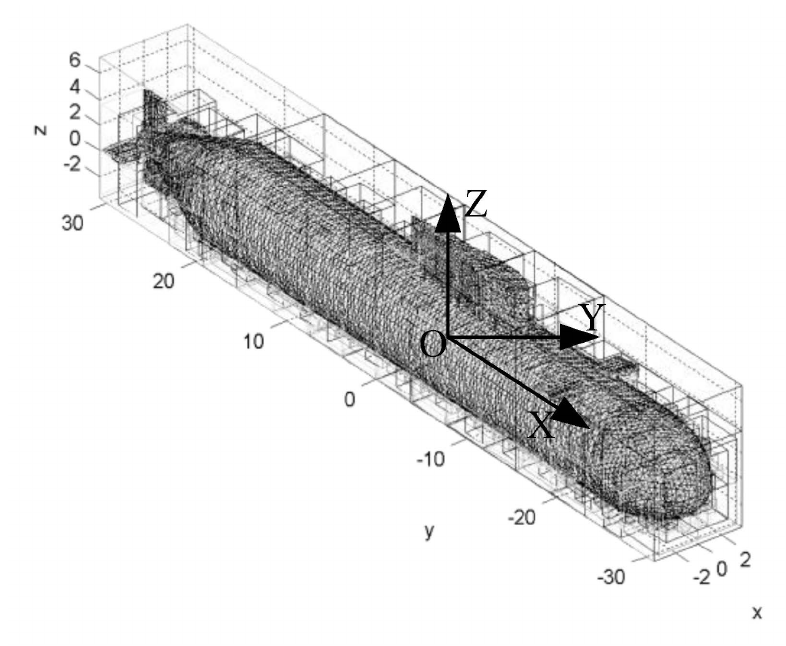
Figure 3. Object subspace partition